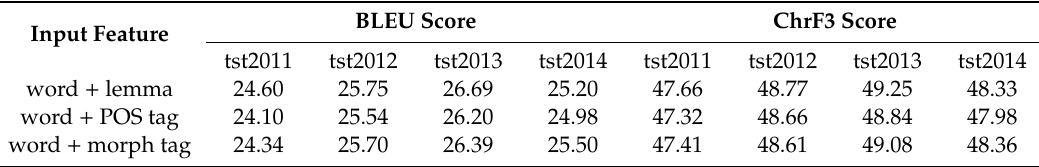
Table 7. The experimental results of incorporating a single linguistic feature into the multi-source model.